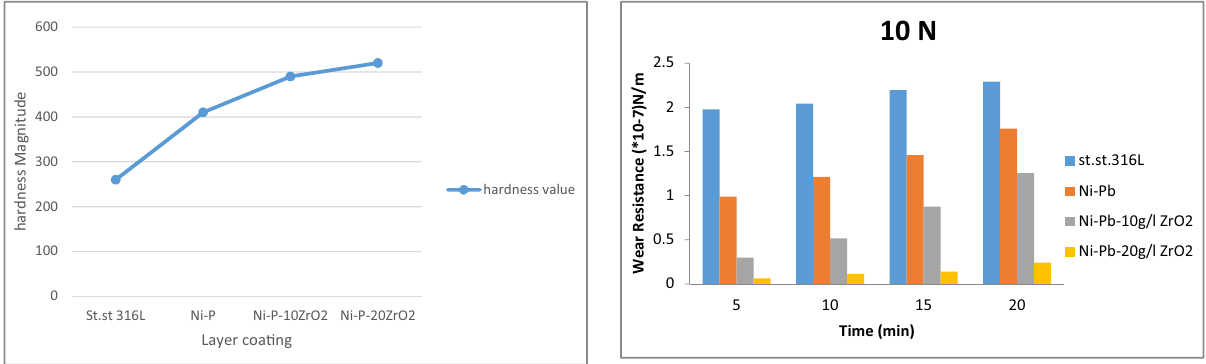
Figure 5: The hardness magnitude for the coated layers. Figure 6: Wear rate of samples at 10 N